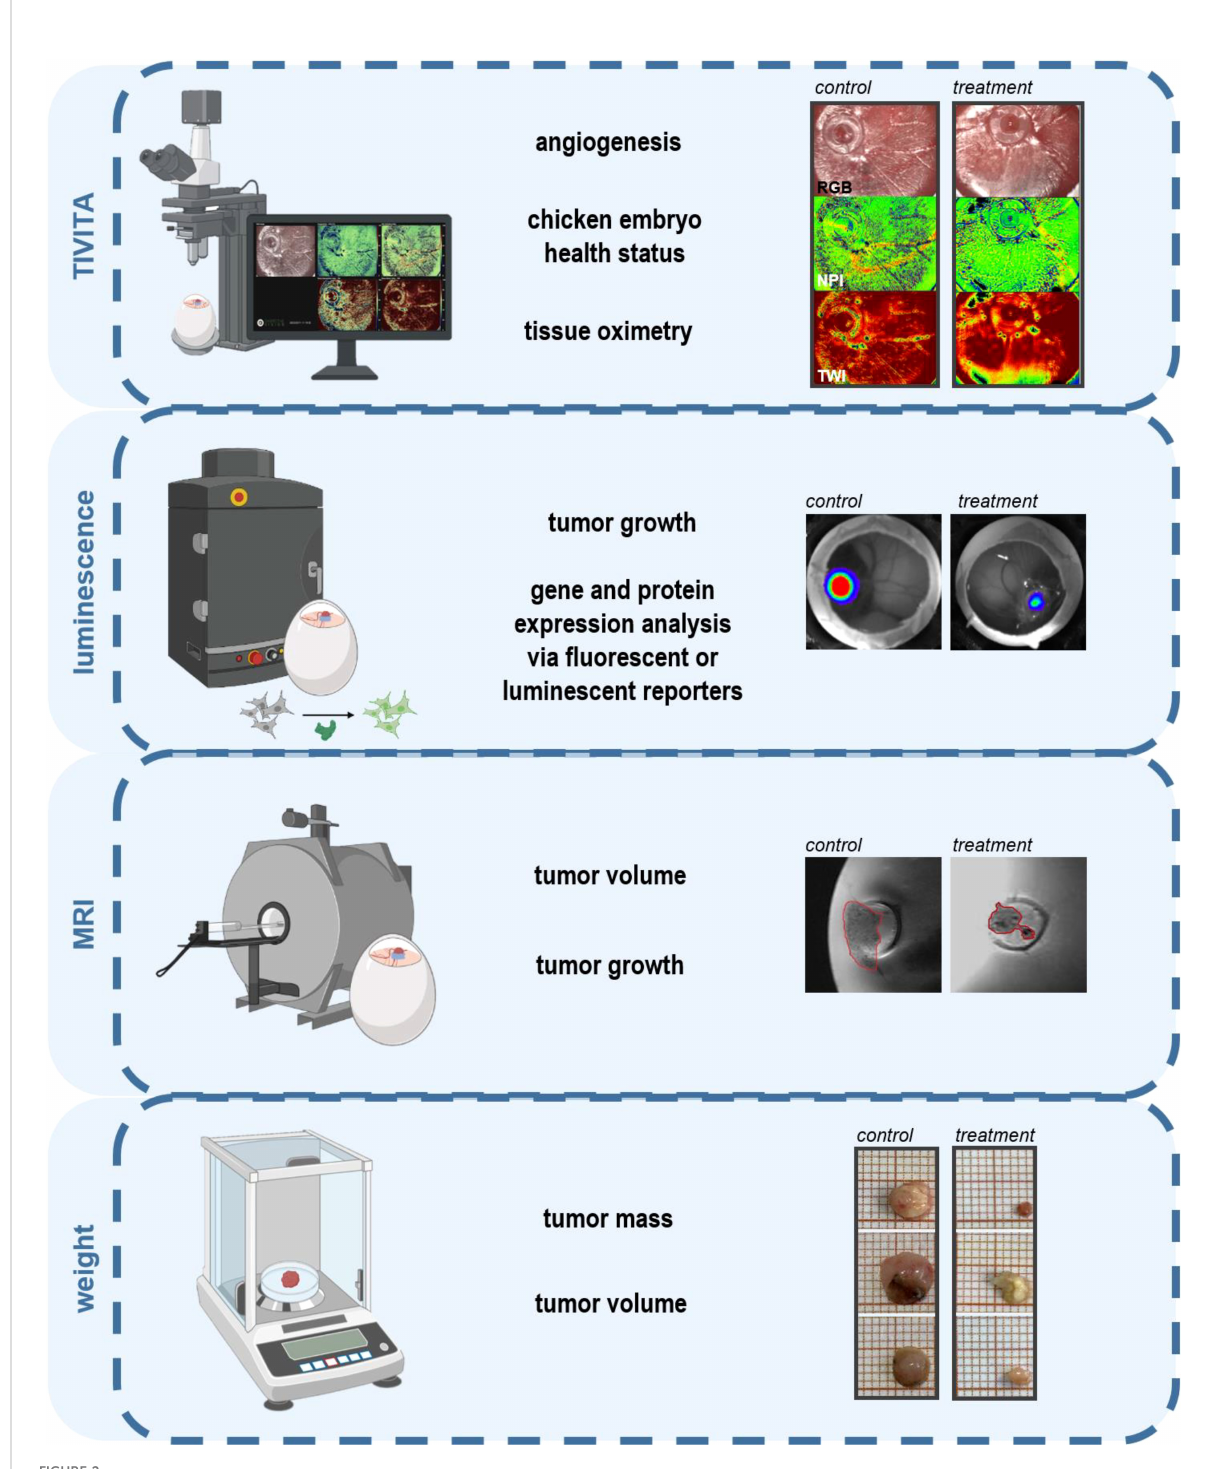
FIGURE 2 Intravital monitoring of angiogenesis, tumor growth, and assessment of tumor weight (11,